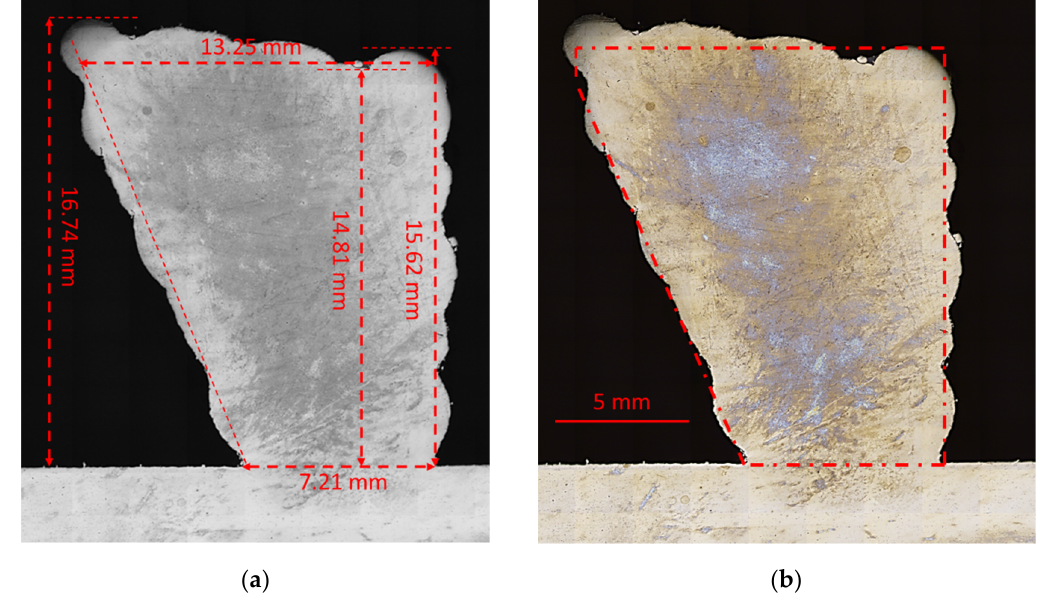
Figure 14. Cross section: ( a ) dimensions; ( b ) compared with the Computer Aided Design (CAD). The sloped side presented maximum dimensional deviations on the horizontal axis, in relation with the target geometry of 0.51 mm and −0.48 mm, on a line where the negative value represents a lack of material. The straight side presented maximum deviations on the horizontal axis regarding the target geometry of 0.67 mm and −0.16 mm. The maximum and minimum height on the vertical axis generated maximum deviations in relation with the target value of 1.14 mm and −0.79 mm. The